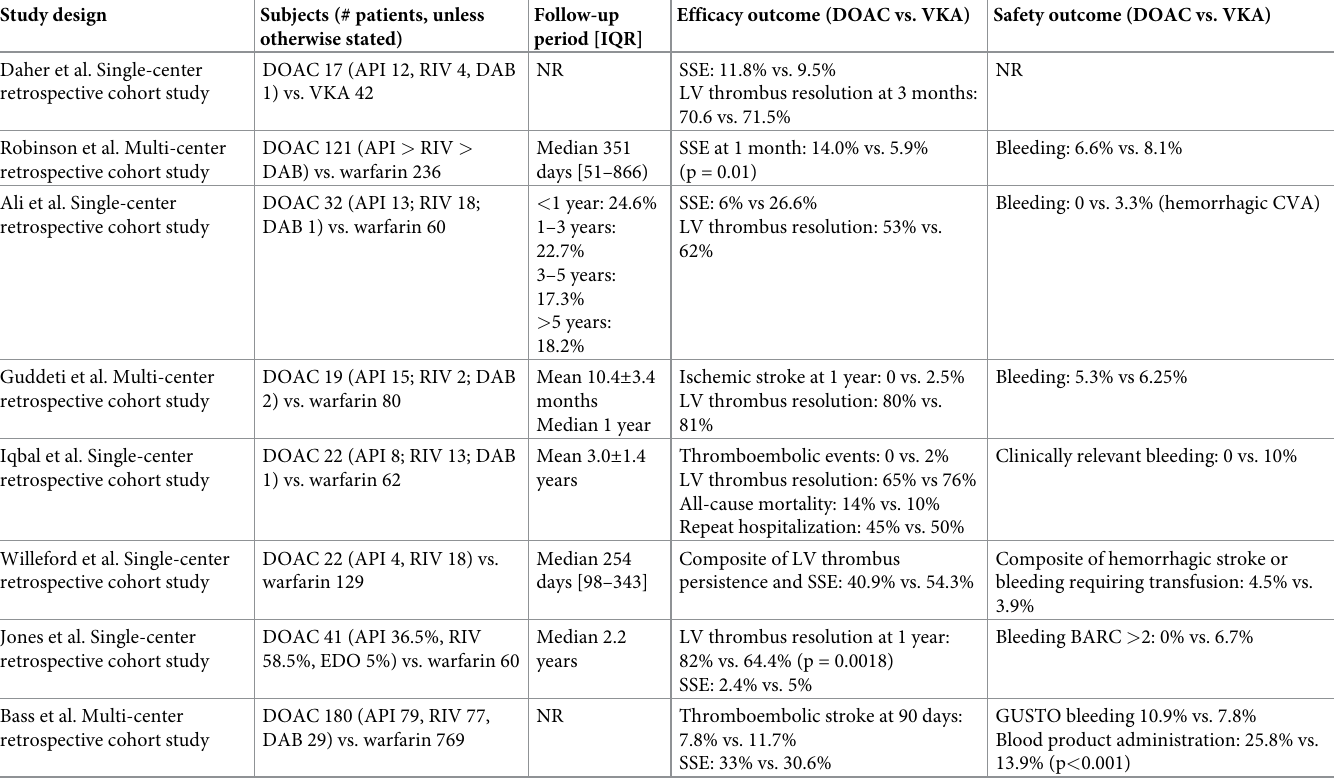
Table 2. Key study design characteristics and results of included studies.